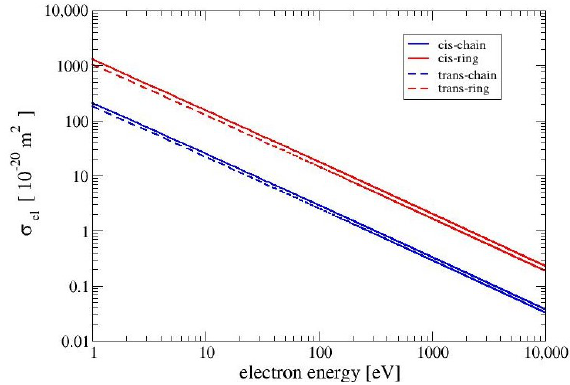
Figure 2. Elastic cross sections for the four conformers.